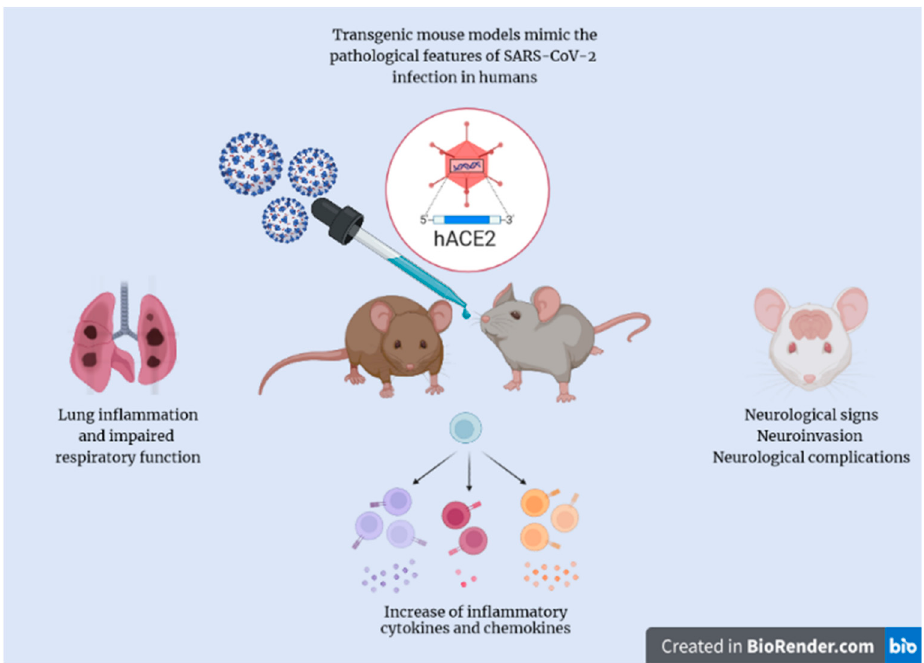
Figure 2. hACE2 transgenic mouse. Expression of hACE2 in the mouse offer the possibility of examining different aspects of SARS-CoV-2 infection.